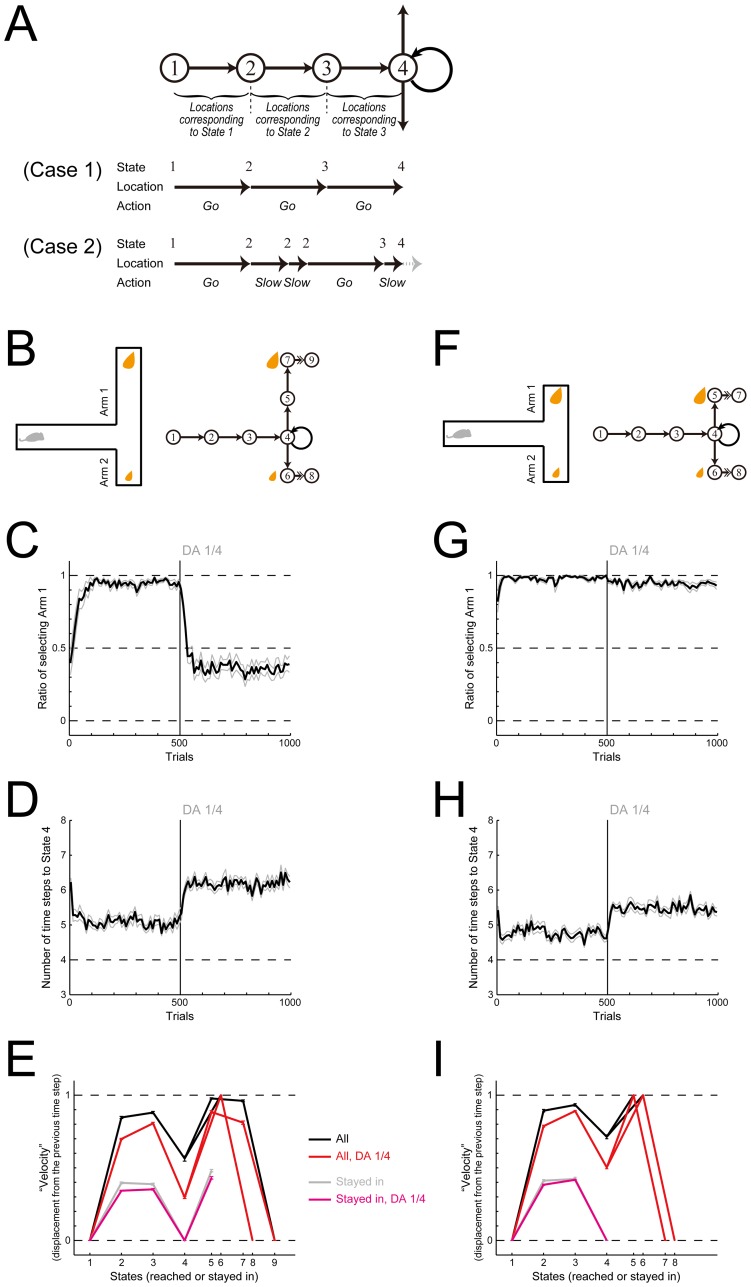
Simulations of the cost-benefit decision making task in a T-maze by an elaborated model, aiming at reproducing the velocity profiles observed in a (different) T-maze task.(A) Schematic explanation of the elaborated model. The one-to-one correspondence between the subject's physical location and the internal state assumed in the original model was changed into a loose coupling, in which each state corresponds to a range of physical locations as illustrated. At each time step, subject at a given location chooses either ‘Go’ or ‘Slow’, except that the subject is at the start, the T-junction, or the reward location (in the ends of the T-maze). By selecting ‘Go’, subject moves straightforward for a time step with the "velocity" 1, meaning that the subject's physical location is displaced by 1, unless there is a physical constraint. By selecting ‘Slow’, subject moves straightforward for a time step with the "velocity" halved, meaning that the subject's physical location is displaced by the half of the displacement during the previous time interval, unless there is a physical constraint. At the start (State 1), subject was assumed to take ‘Go’ or ‘Stay’, and at the T-junction (State 4), subject was assumed to take ‘Go’ to either of the two arms or ‘Stay’, in the same manners as in the original model. (Case 1) shows the case where subject at the start point chooses ‘Go’ three times in succession, whereas (Case 2) shows the case where subject chooses ‘Go’, ‘Slow’, ‘Slow’, ‘Go’, and ‘Slow’. Notably, in Case 2, subject transitions from State 3 to State 4 by choosing ‘Slow’ rather than ‘Go’. (B) Schematic diagram of the task condition where there are high-cost-high-return and low-cost-low-return options. When reaching reward, subject is assumed to take the consummatory action (indicated by double-lined arrows). (C,D) Ratio of choosing the large-reward arm (Arm 1) (C) and the average number of time-steps towards the T-junction (State 4) (D). DA depletion (to the quarter of the original) after 500 trials was simulated as before. The configurations are the same as those in Fig 5B and 5C. (E) Average "velocity", i.e., displacement from the previous time step, when subject reached or stayed in each state (horizontal axis). The black and red solid lines indicate the "velocity" averaged across all the cases in 251–500 trials (before DA depletion) and 751–1000 trials (after DA depletion), respectively. The gray and magenta lines indicate the "velocity" averaged across the cases where subject stayed in the state at the previous and current time steps: notably, because of the decoupling of the physical location and the internal state, subject can still move. The error bars indicate the mean ± SE of 20 simulations (black and red) or of simulations (out of the total 20) which had the corresponding data (gray and magenta). (F-I) Same as (B-E) for the different task condition where there are low-cost-high-return and low-cost-low-return options.